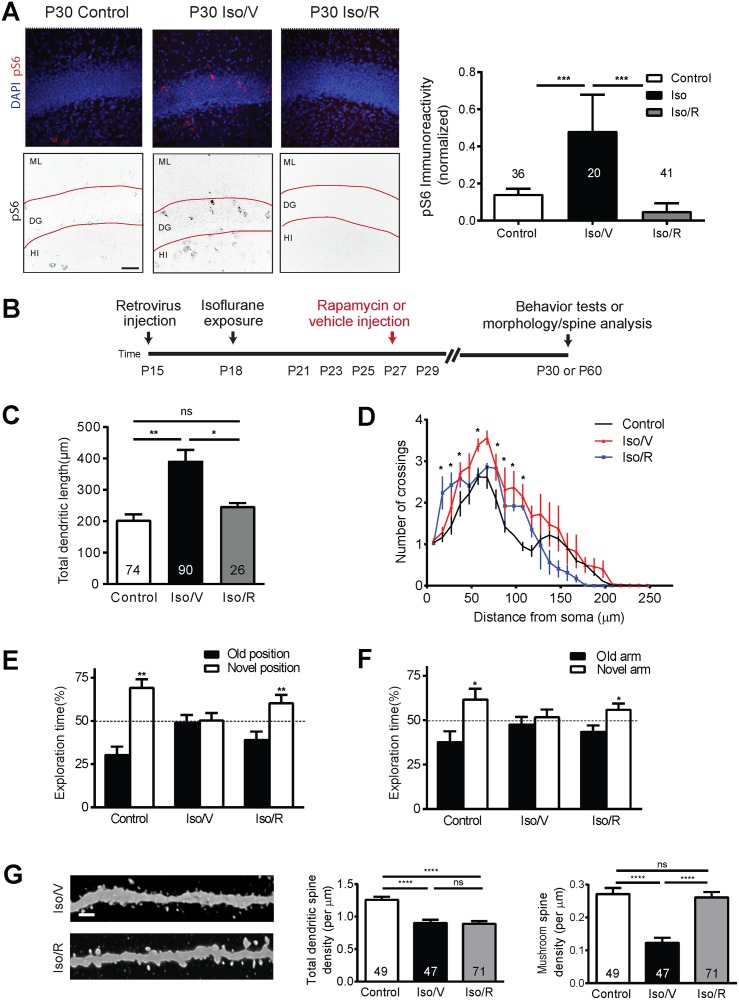
Isoflurane exposure leads to aberrant activation of the mechanistic target of rapamycin (mTOR) signaling pathway, and pharmacological inhibition of the mTOR activities rescues deficits in behavioral tests and loss of spines.(A) Representative confocal images of phospho-S6 (pS6) immunofluorescence at postnatal day (P) 30 in the dentate gyrus showing an increase in labeling in the isoflurane plus vehicle (Iso/V) group relative to controls and a return to baseline in the group exposed to isoflurane and subsequently treated with rapamycin, designated Iso/R. The upper panels are original confocal images with DAPI in blue and pS6 labeling in red, and the lower panels are processed for quantification with black pS6 signal on white background (ML, molecular layer; DG, dentate gyrus; HI, hilus, scale bar: 50 μm). Also shown in (A) quantification of normalized pS6 expression in the dentate gyrus granule cell layer (***p < 0.001, ANOVA, numbers in each bar represent n for images analyzed). (B) Schematic diagram of rapamycin treatment for behavior tests and spine analysis. Summaries of total dendritic length (C) and Sholl analysis of dendritic complexity (D) of GFP+ neurons show a rescue of normal dendritic arbor length and complexity with Iso/R. Values represent mean ± SEM (*p < 0.05, **p < 0.01; ANOVA for C; *p < 0.0001 ANOVA for D). Numbers in each bar represent number of cells analyzed per group, minimum of 5 animals per group). Summaries of object-place recognition test (E) and Y-maze test (F) for Iso/V and Iso/R show a recovery to near control performance with Iso/R. (Control n = 10, Iso/V n = 11, Iso/R n = 11; *: p < 0.05; **: p < 0.01, Student t test). (G) Representative confocal images of dendritic spines at P60. Scale bar: 2 μm. Shown on right are summary plots of total and mature dendritic spine density. Numbers associated with bar graph indicate the number of dendritic segments examined, a total of 2,586 spines in the control group, 1,831 spines in the isoflurane plus vehicle group, and 2,999 spines in the isoflurane plus rapamycin group were analyzed (****p < 0.0001; ns: non-significant; ANOVA, numbers in each bar represent n of dendritic segments analyzed per group, minimum of 5 animals per group). Underlying data in S1 Data under Fig 3A-G.